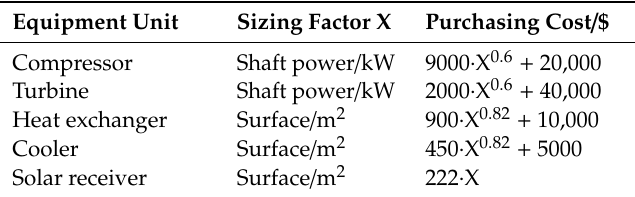
Table 2. Purchasing cost functions for main equipment units.